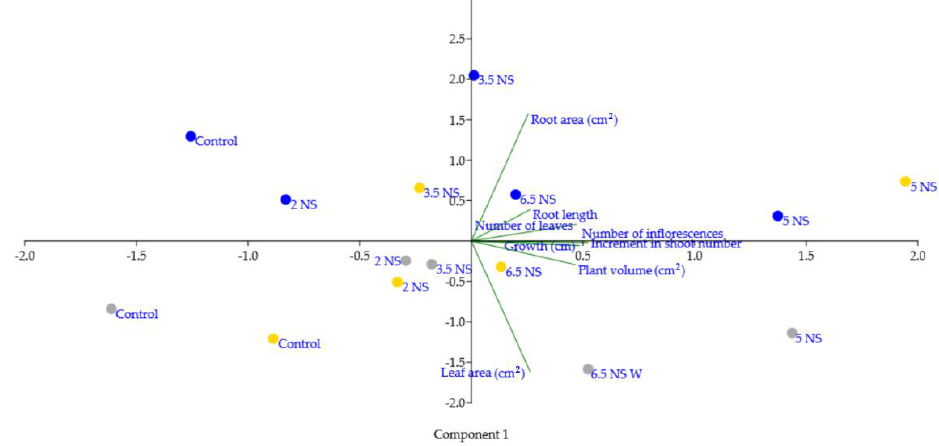
Figure 6. PCA biplot of Viola seedlings based on their EC and development. Colored dots represent the type of seedlings (grey — White Viola seedlings; blue — Blue Viola seedlings; golden — Yellow Viola seedlings).